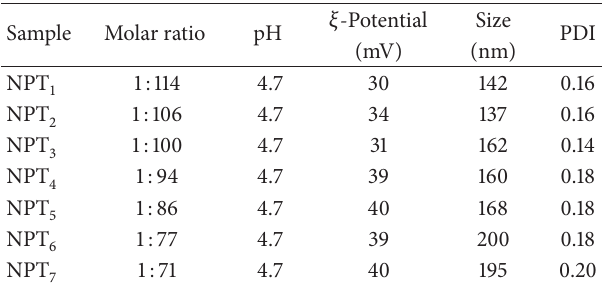
Table 1: 𝜉 -Potential and size, effect of Ch-SH/TPP molar ratio concentration 0.5